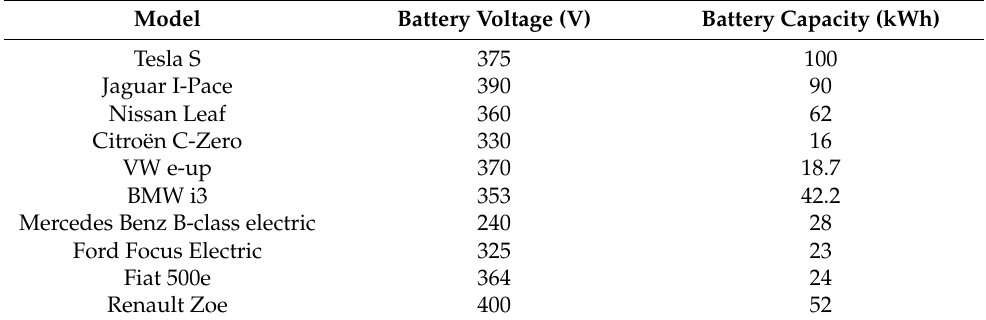
Table 3. Some EV electric parameters 1 .